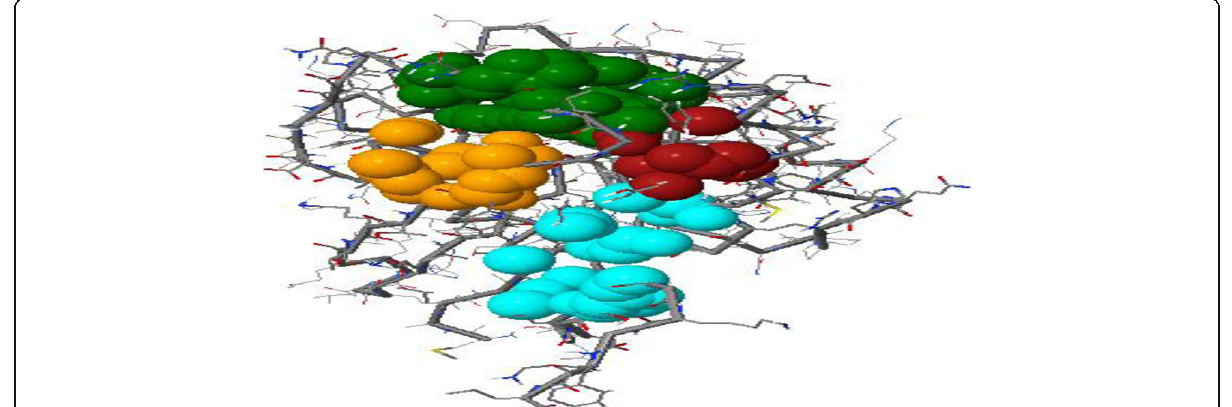
Fig. 7 The binding cavities of Rab39a obtained from CASTp server [22]: Site1 is represented in green, site 2 in orange, site 3 in cyan and site 4 in pink